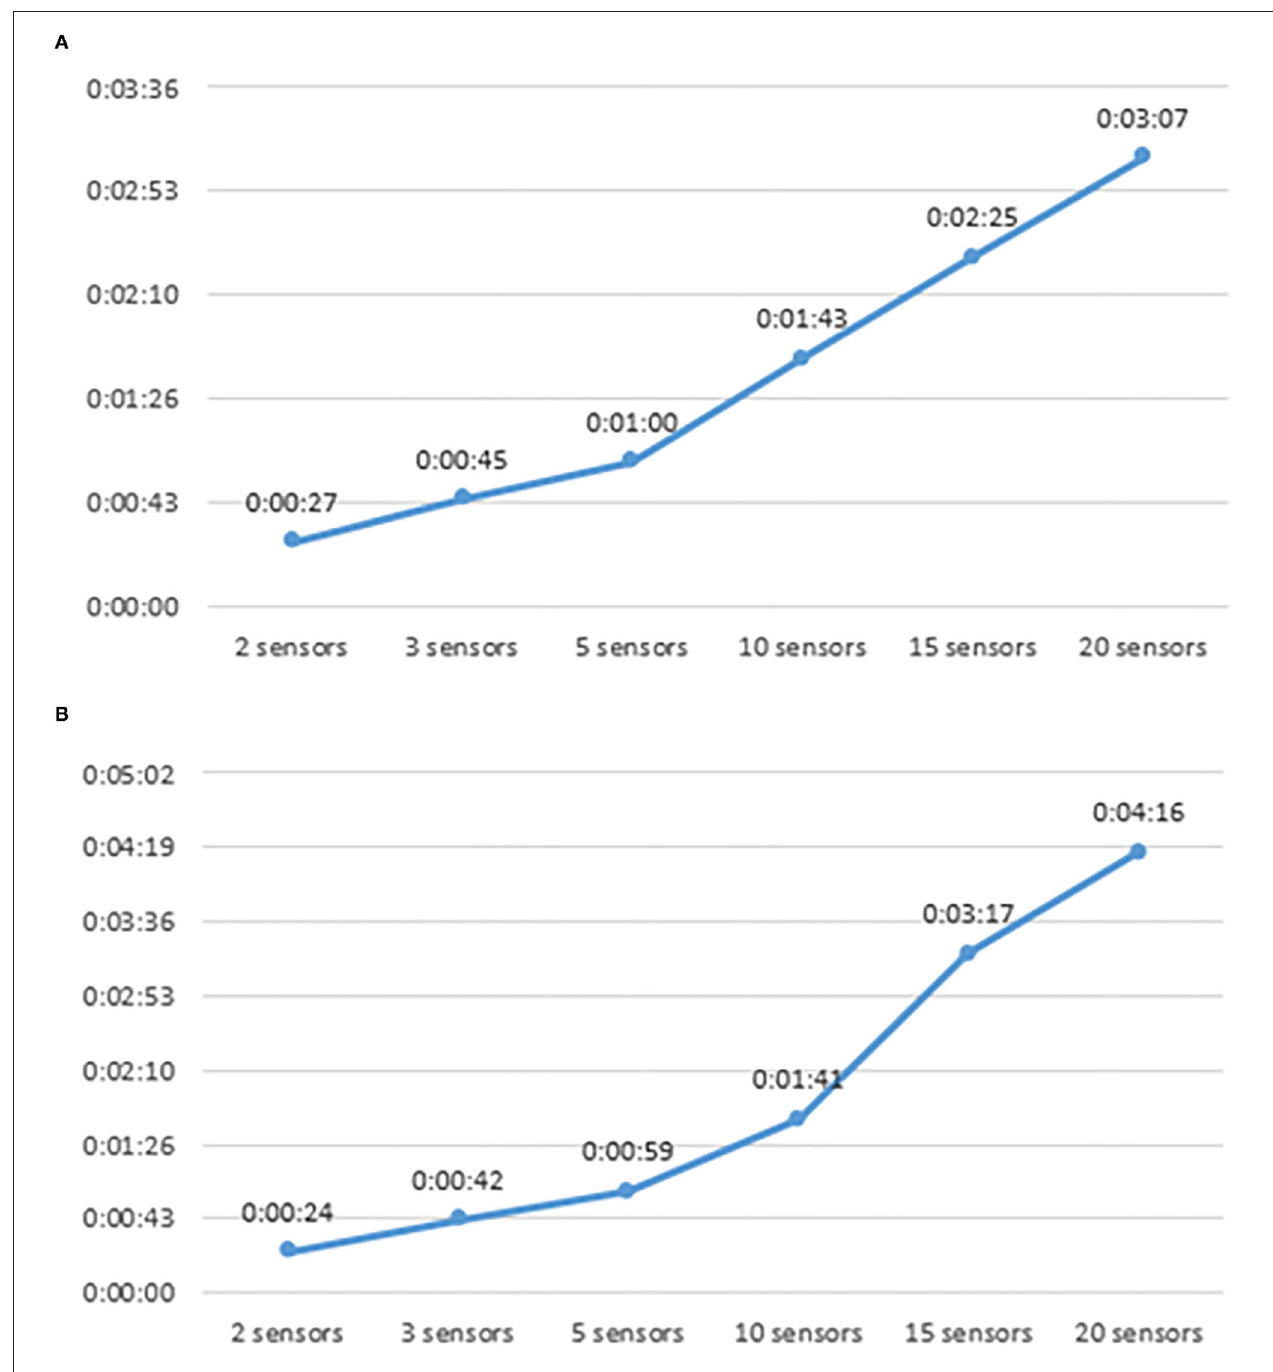
FIGURE 3 | Pattern orchestrator (A) and pattern engine (B) reasoning